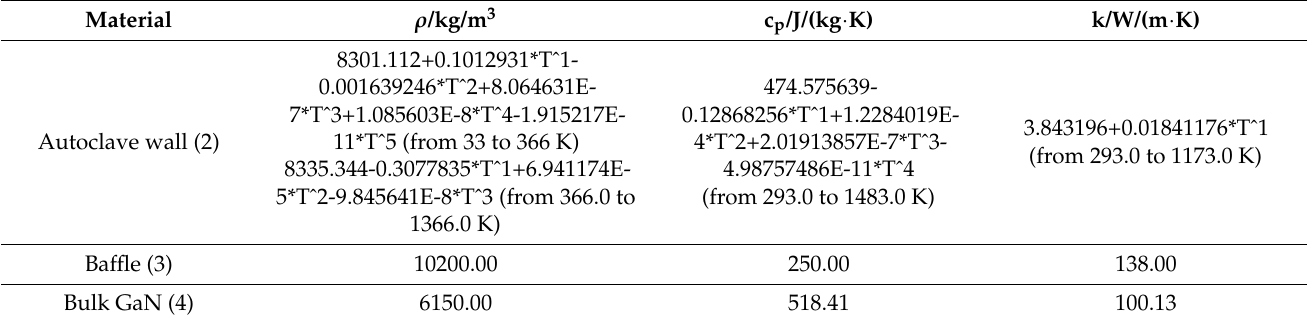
Table 5. Materials properties of the solid components. For the autoclave walls, the in-build materials property definitions for the nickel base superalloy Haynes R-41 of the Comsol Multiphysics materials library were